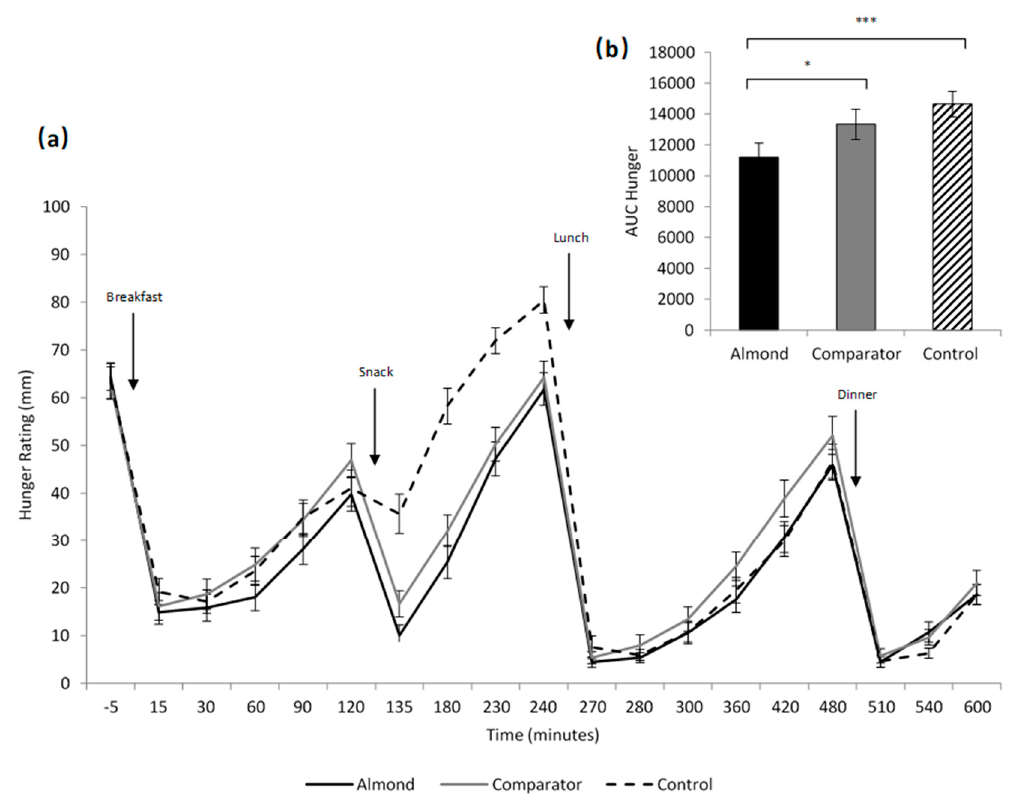
Figure 2. Subjective ratings of hunger ( a ) and area under the curve hunger ( b ) for the three different snack conditions. * p < 0.05; *** p < 0.001.